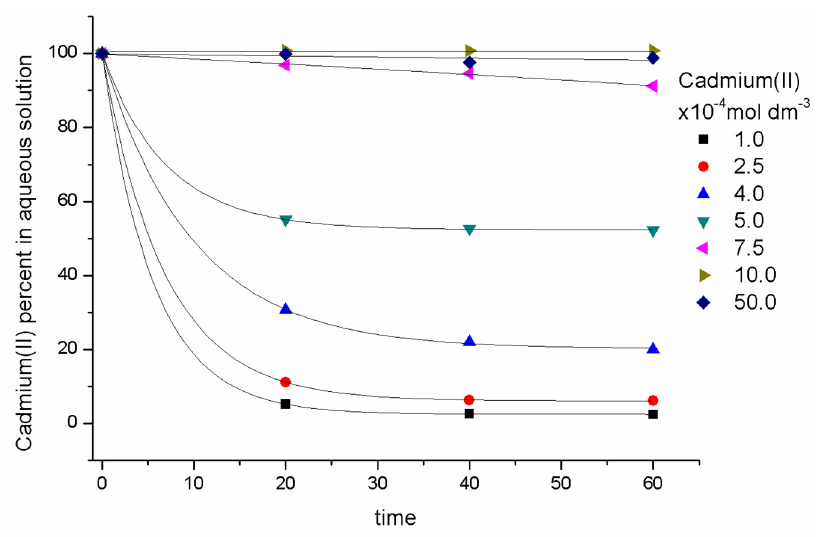
Figure 2. Cadmium (II) concentration profiles in the aqueous phase (pH = 8, 1 × 10 − 3 mol dm − 3 TRIS) for different initial concentrations. PIM: 23.4% CTA, 54.5% NPOE, and 21.1% Kelex 100 ( w / w ).